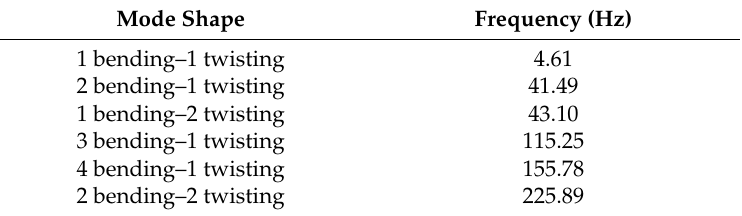
Table 3. First six bending-twisting mode shapes and natural frequencies of the PZTs covered plate wing.